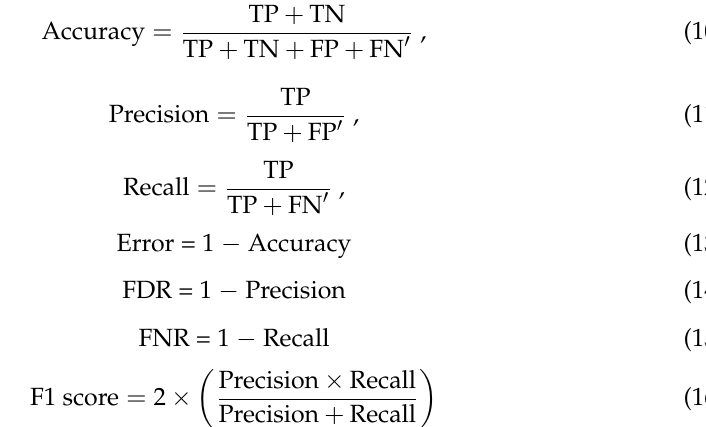
Table 4. Selection of Experimental Parameters.